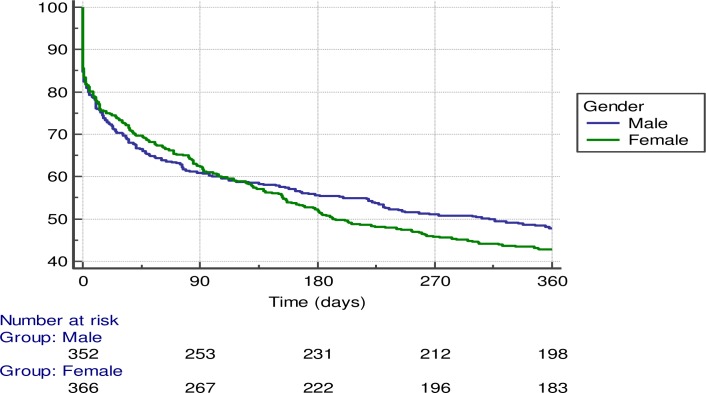
Kaplan-Meier survival curves and gender.